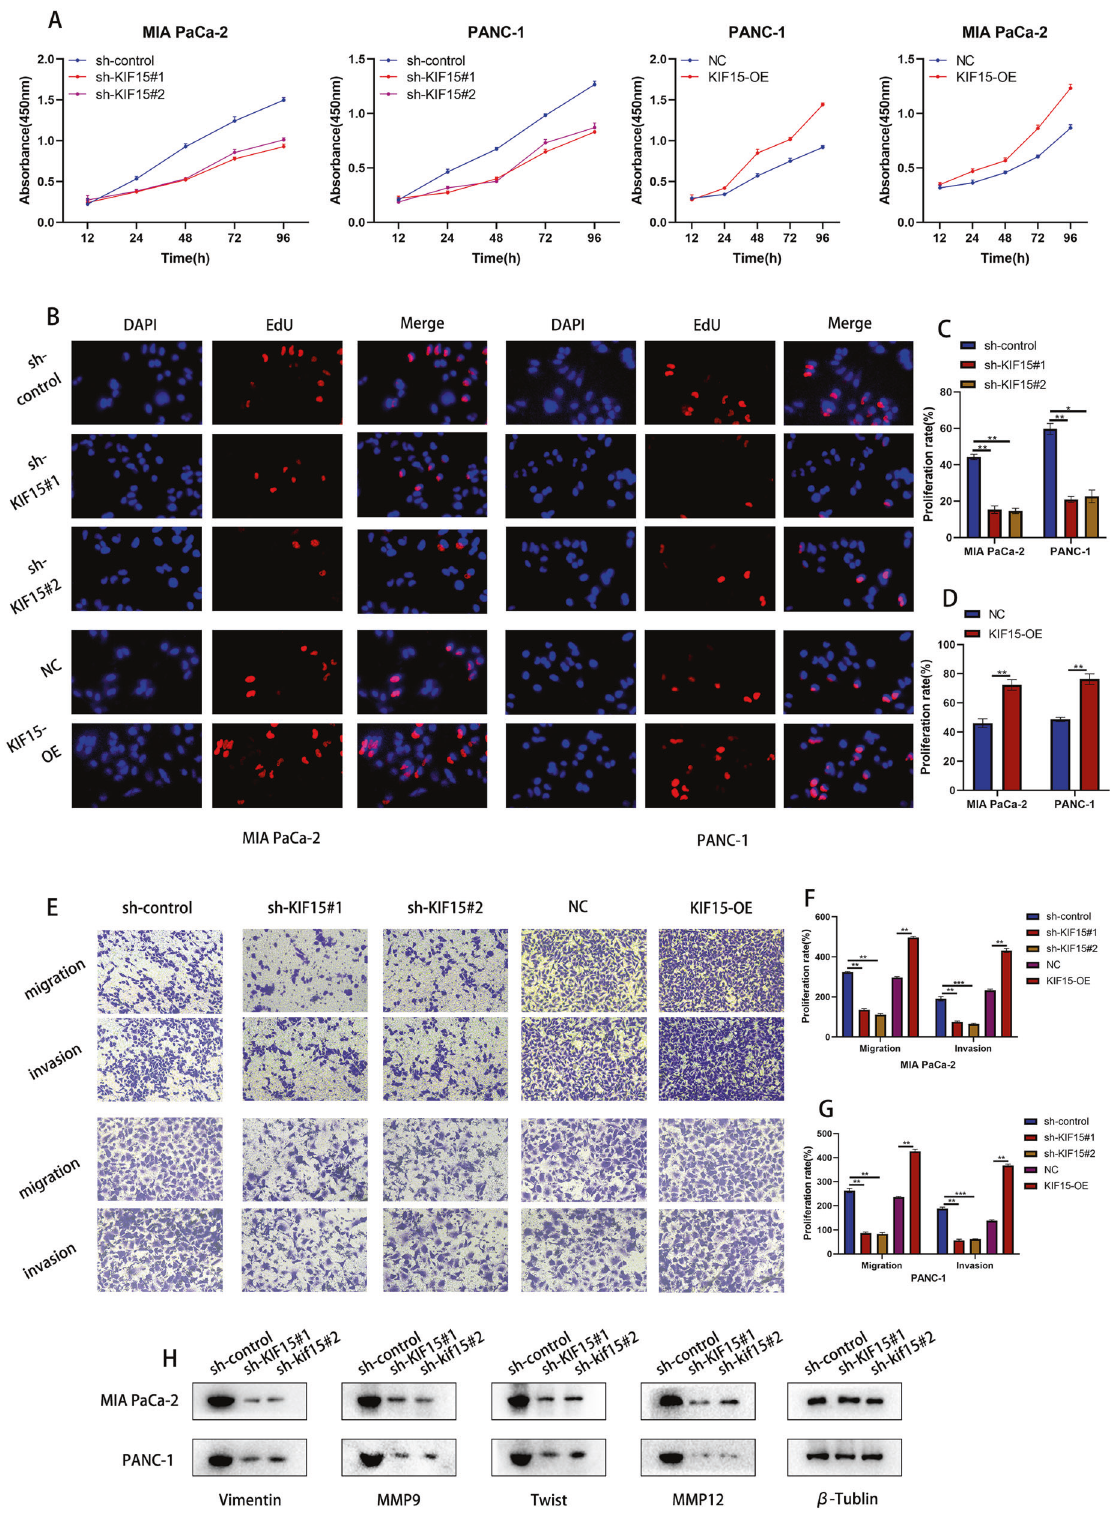
Fig. 2 KIF15 promoted the malignant phenotype of PC cells. A The proliferation rate of PC cells measured by CCK-8 assay. B The EdU assay of PC cells transfected with different plasmids. C The quanti fi cation of EdU assay in PC cells transfected with sh-control plasmid or KIF15 shRNA plasmids. D The quanti fi cation of EdU assay in PC cells transfected with negative control plasmid or KIF15 overexpression plasmids. E The transwell assay pf PC cells transfected with different plasmids. F The quanti fi cation of transwell migration assay in PC cells. G The quanti fi cation of transwell invasion assay in different group of PC cells. H The western blot assay in PC cells transfected with corresponding plasmids. Cell Death and Disease (2023)